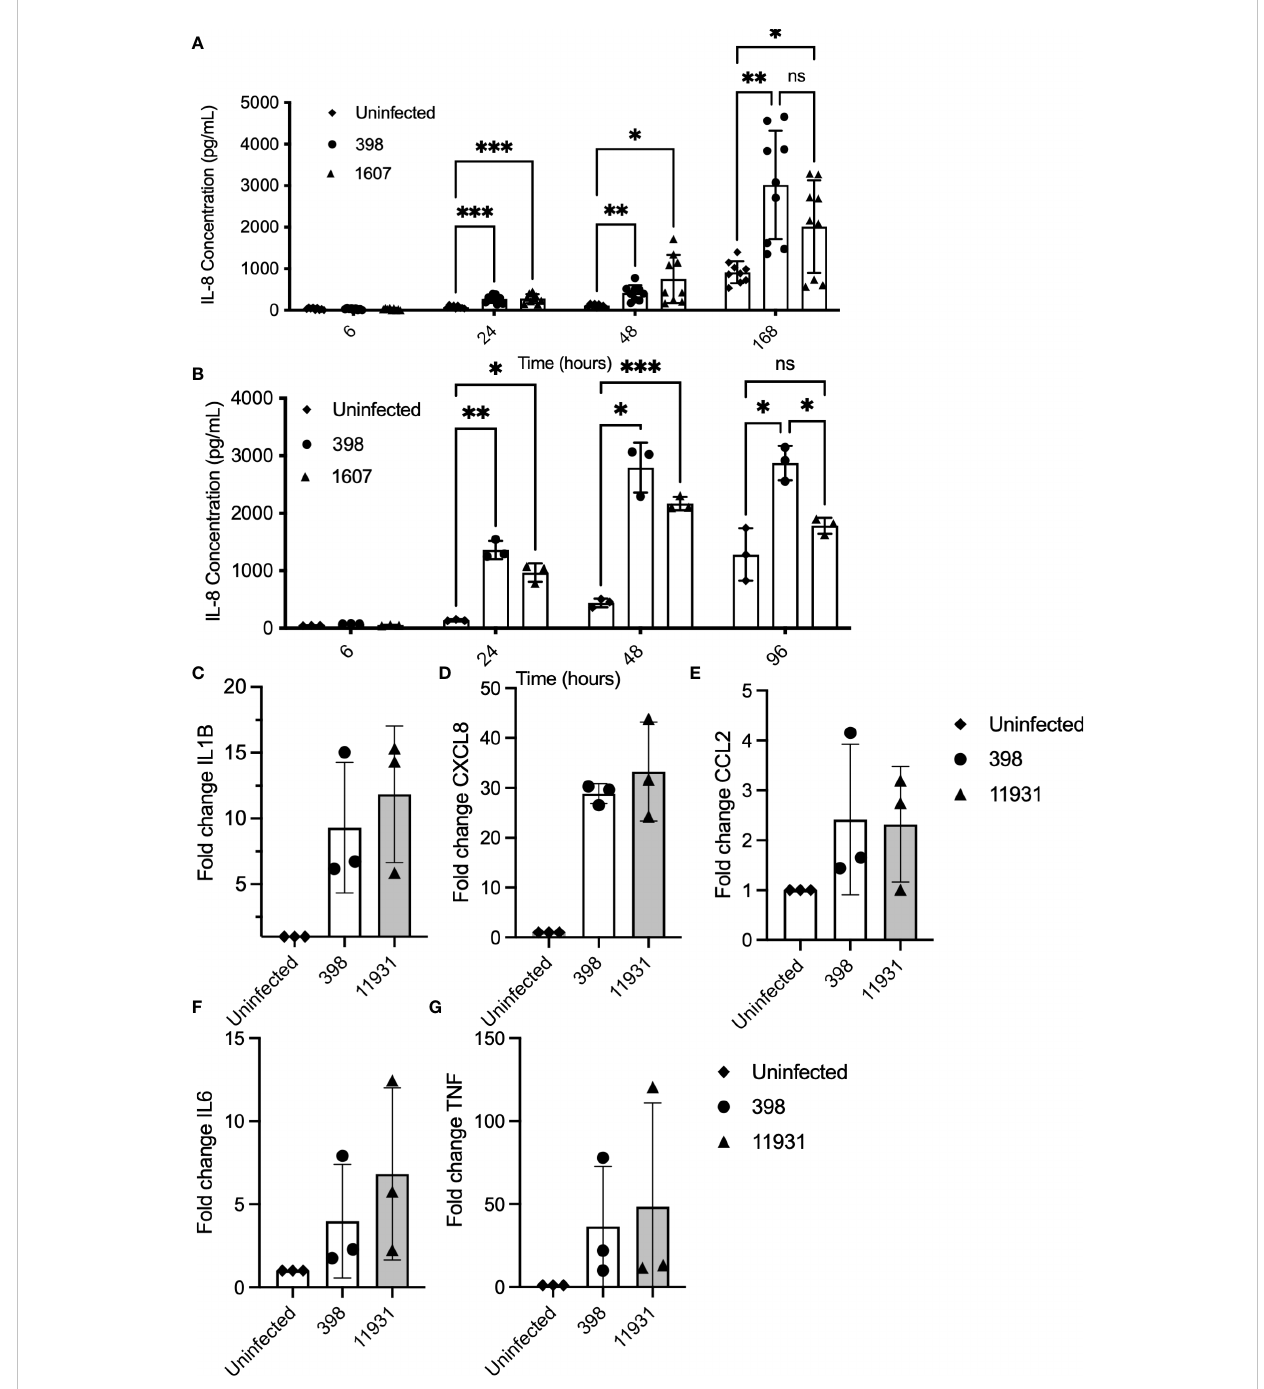
FIGURE 3 Cytokine induction in response to NTHi infection occurs independently of on internalization rate. PBECs and NECs in serum-free submerged culture were inoculated with a highly internalized strain (398) and less internalized strain (1607). Supernatants were collected at various timepoints and levels of IL-8 (CXCL8) were evaluated using ELISA. (A) IL-8 production was signi fi cantly induced in cells treated with either strain of NTHi from 24 hours post-infection. IL-8 production did not differ signi fi cantly between strains at any time point. Signi fi cance was evaluated using 2-way ANOVA with Sidaks multiple comparison tests to evaluate signi fi cance between each treatment and timepoint. n=3 biological replicates. (B) IL-8 production was elevated in NECs at 24 and 48hpi after exposure to NTHi. Signi fi cance was evaluated using 2-way ANOVA with Sidaks multiple comparison tests to evaluate signi fi cance between each treatment and timepoint. n=3. (C – G) . When evaluated using qPCR, infection with a more highly internalized NTHi strain did not correlate with more robust immune activation in Calu-3 cells inoculated with NTHi strains 398 (high internalization) compared with NTHi lab strain 11931 (low internalization). Each marker was signi fi cantly increased in cells treated with NTHi, but there was no signi fi cant difference in induction between strains. Signi fi cance was evaluated using 2-way ANOVA with Sidaks post-hoc multiple comparisons tests to evaluated the difference between strains. n=3 biological replicates with 2 technical replicates each. Throughout, **** corresponds to P ≤ 0.0001, *** indicates P ≤ 0.001, ** means P ≤ 0.01, * indicates ≤ 0.05, anything P > 0.05 is